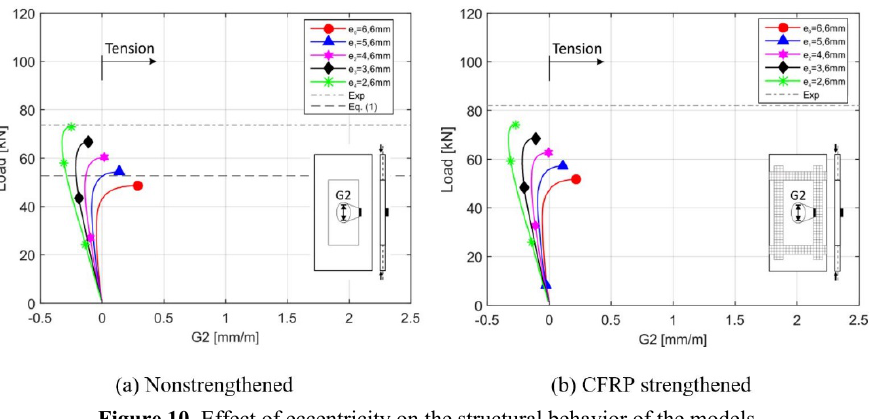
Figure 10. Effect of eccentricity on the structural behavior of the models.